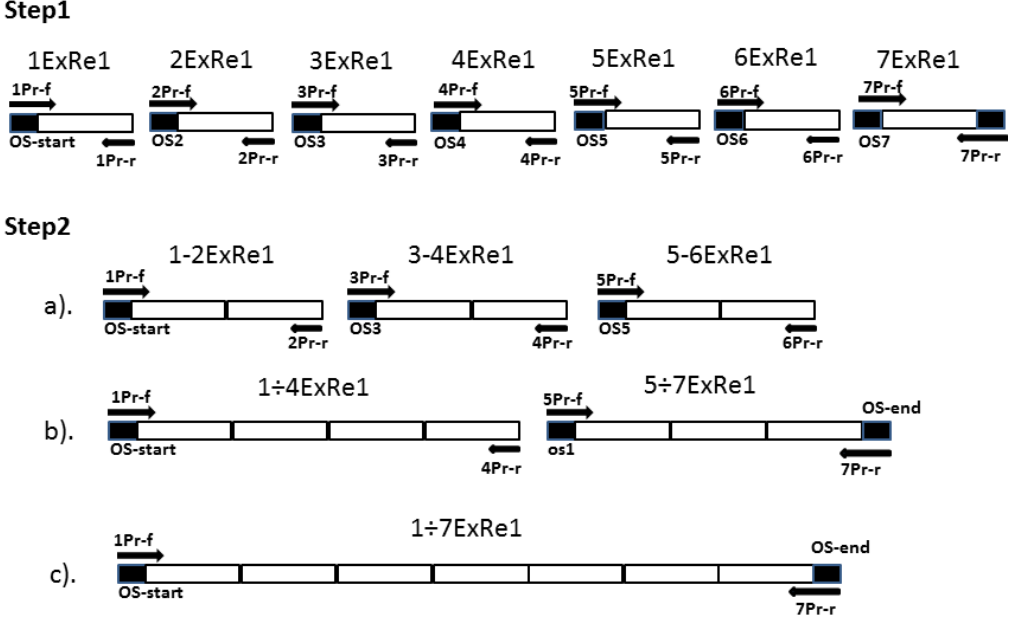
Figure 1. The schematic diagram illustrating the construction of a full-length coding sequence of hRenalases. Step1: Seven individual exons of hRenalase1 (1ExRe1/7ExRe7) with overlapping sequences (OS) were amplified by means of corresponding forward (Pr-f) and reverse (Pr-r) primers; Step2: The amplified exons were sequentially linked together by overlapping PCR. ( a ) 1ExRe1 with 2ExRe1, 3ExRe1 with 4ExRe1, 5ExRe1